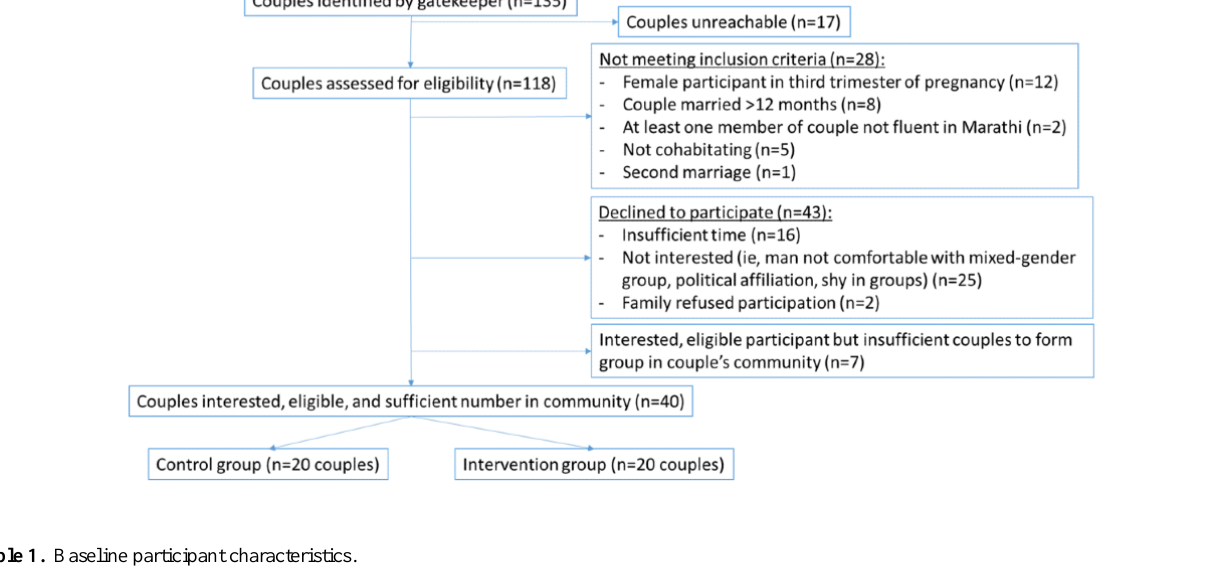
Table 1. Baseline participant